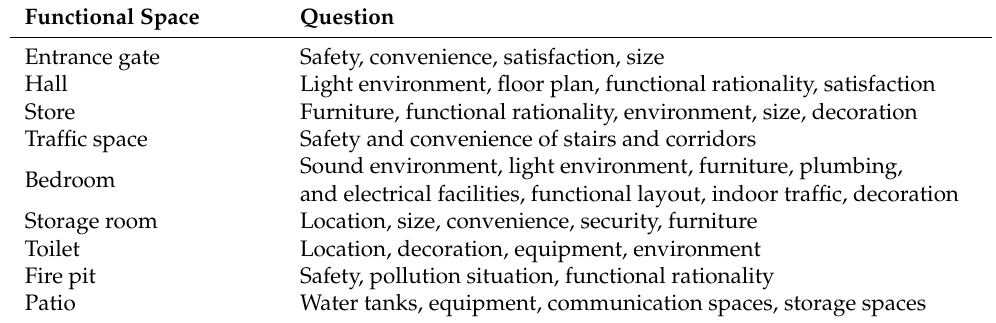
Table 2. Content of interviews on the residential environment of the elderly in ancient